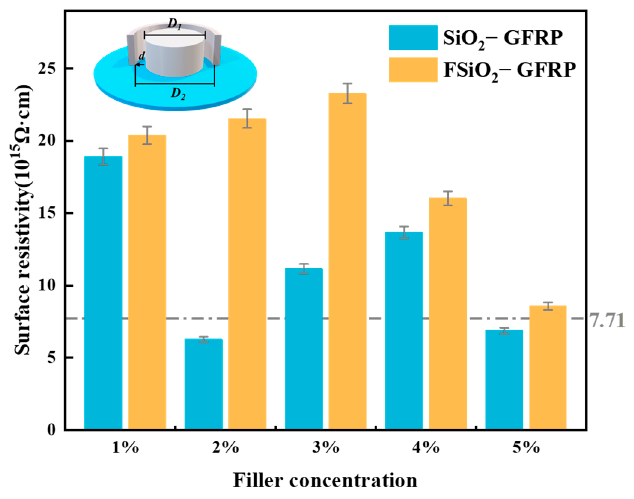
Figure 9 . Surface resistivity of GFRP samples. Figure 9. Surface resistivity of GFRP